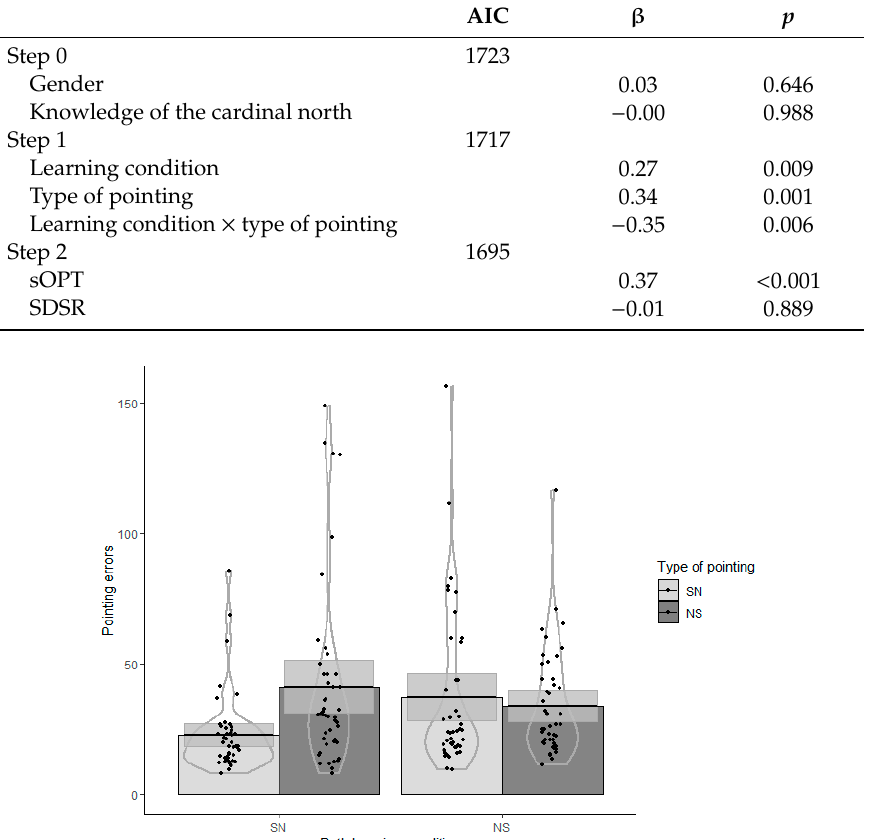
Figure 2. Pointing task. Learning condition × Type of pointing (SN = south to north; NS = north to south).